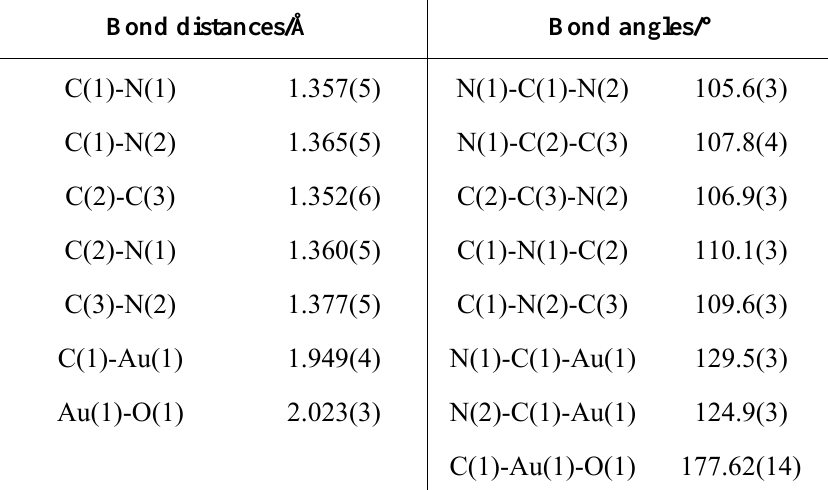
Table 2. Selected bond distances (Å) and angles (°) for compound 5